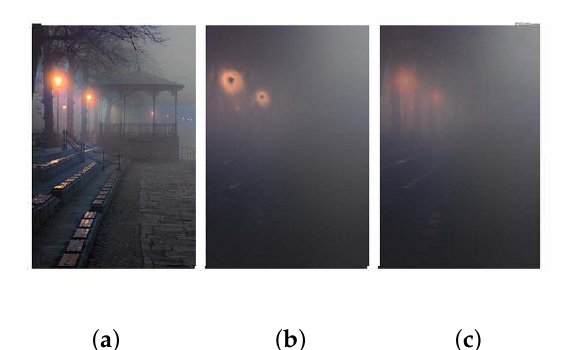
Figure 6. The illumination maps obatined by different guide images. ( a ) Hazy image. ( b ) The guide image is an image obtained by filtering the channel difference map; ( c ) The guide image is an image obtained by filtering the input image